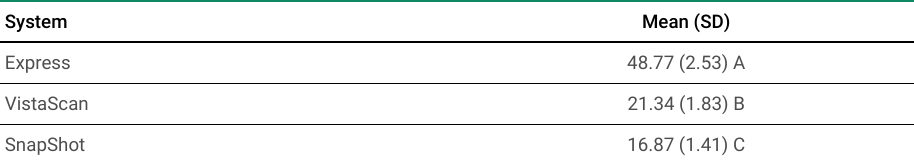
Different letters indicate statistical